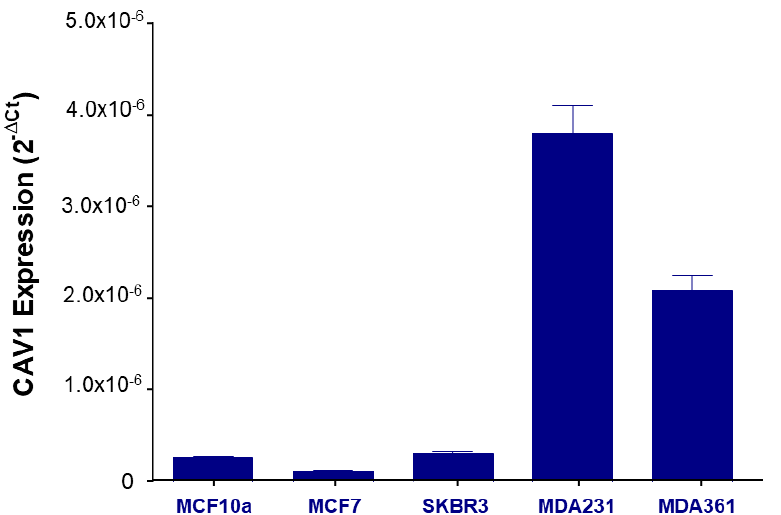
Figure 7. Caveolin-1 expression in breast cancer cell models. Different levels of Caveolin-1 mRNA expression in all the analyzed breast cancer cell lines. In MDA-MB-231 cells, the expression of Caveolin-1 mRNA was found to be higher (~5.0 × 10 − 6 ) compared to the other cell lines (values from ~0.2 × 10 − 6 to ~2.0 × 10 − 6 ) The relative expression was determined using the 2 − ∆ Ct method. Caveolin-1 relative expression is shown as the mean +/ − SD of three technical independent experiments.